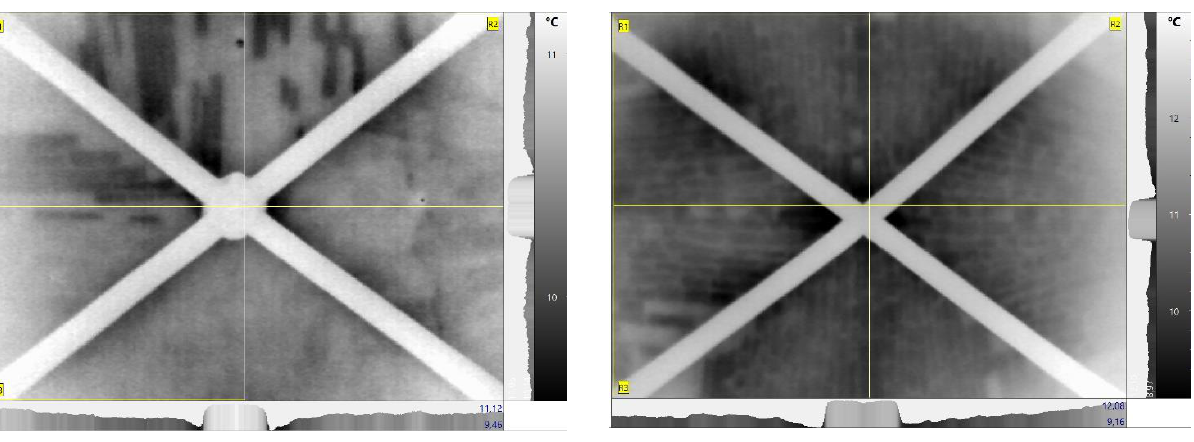
Figure 7: Thermogram of bay eight with the highest amount of thermally more inert stone fabric